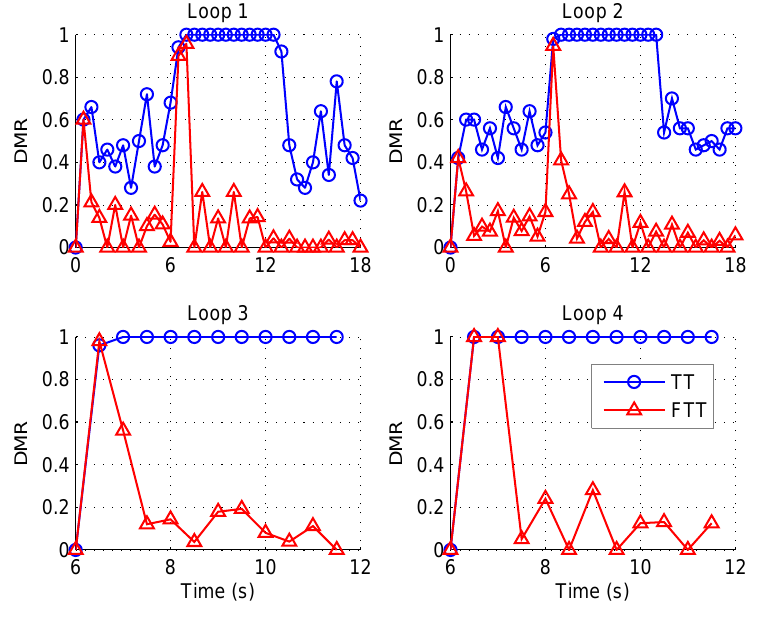
Figure 6. Deadline miss ratio under system